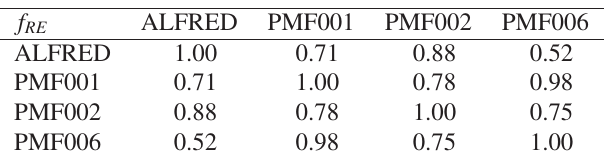
Table 2. k ef f uncertainty quantification for ALFRED with Table 4. Representativity factor of the experiments used in the ENDF / B-VIII.0. assimilation for JEFF-3.3.